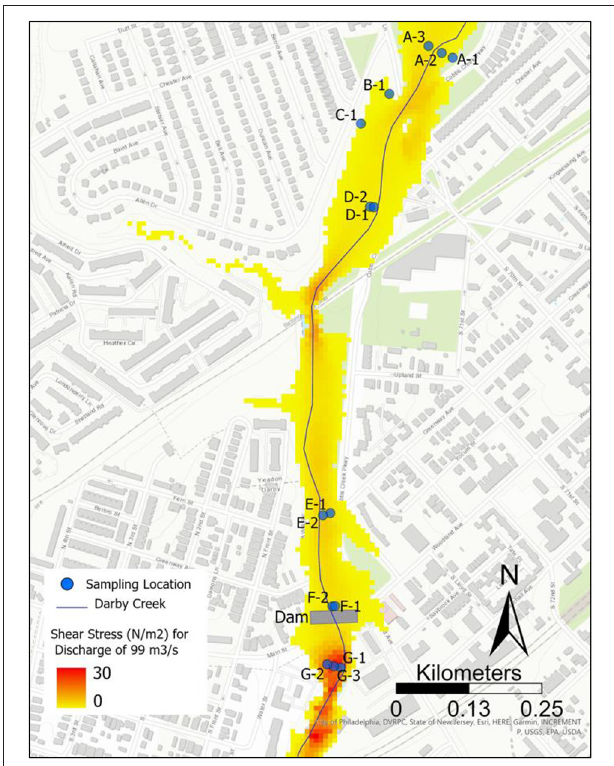
FIGURE 5 | Simulated shear stress distribution obtained from the geomorphologic model for the sampling